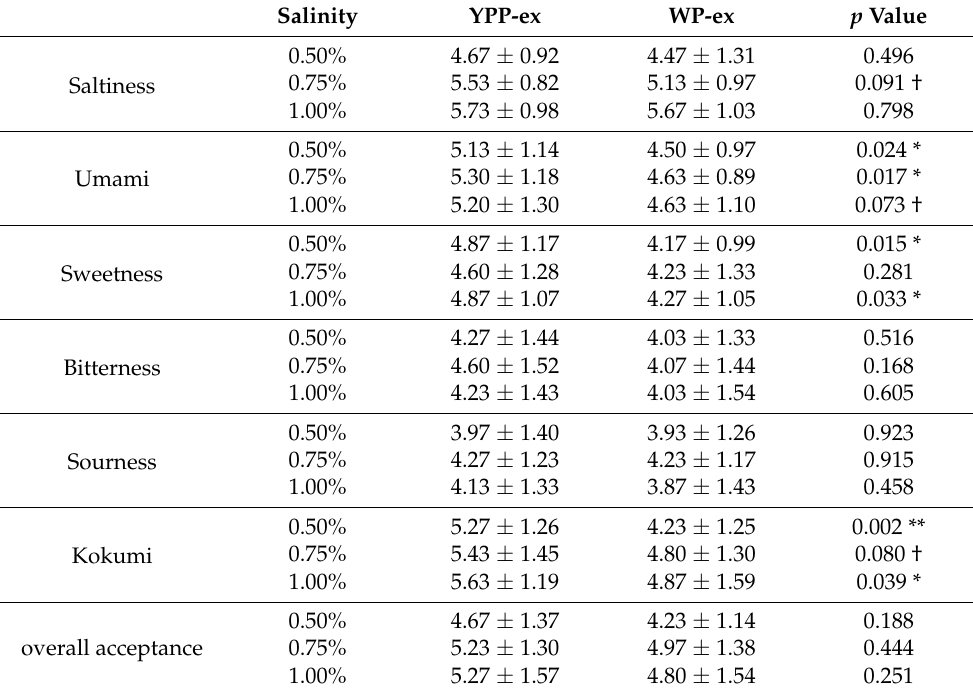
Table 2. Sensory evaluation results of hot water extracts samples. Salinity YPP-ex